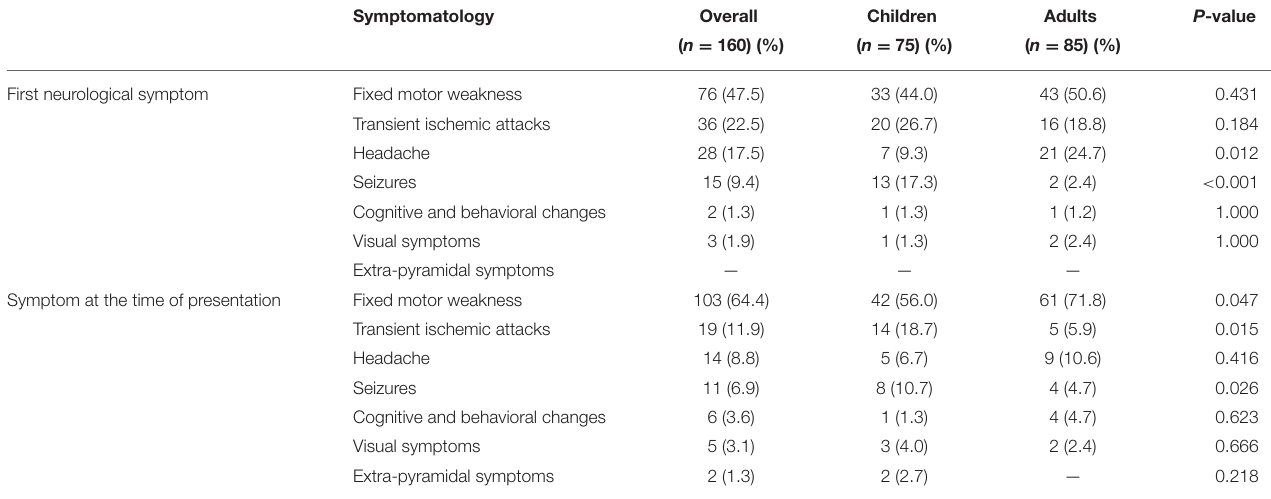
TABLE 2 | Symptomatology of MMA patients at different instances of disease